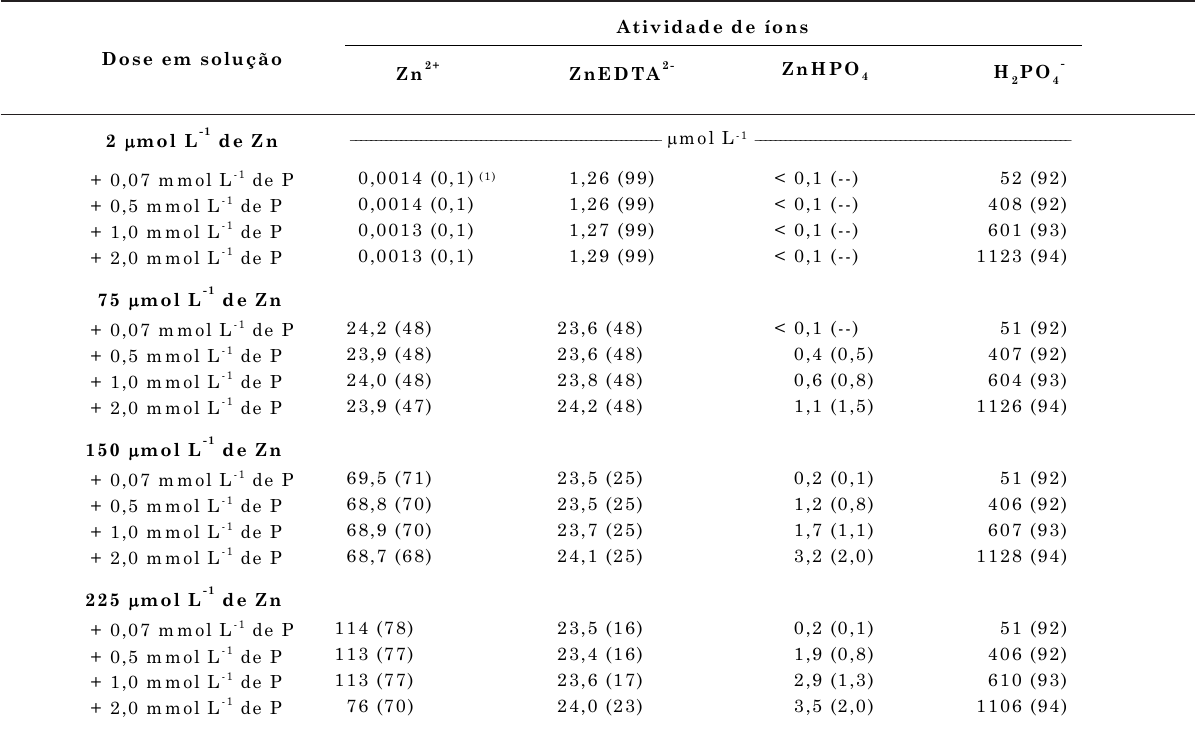
(1) Valores entre parênteses representam a percentagem da concentração total do componente.